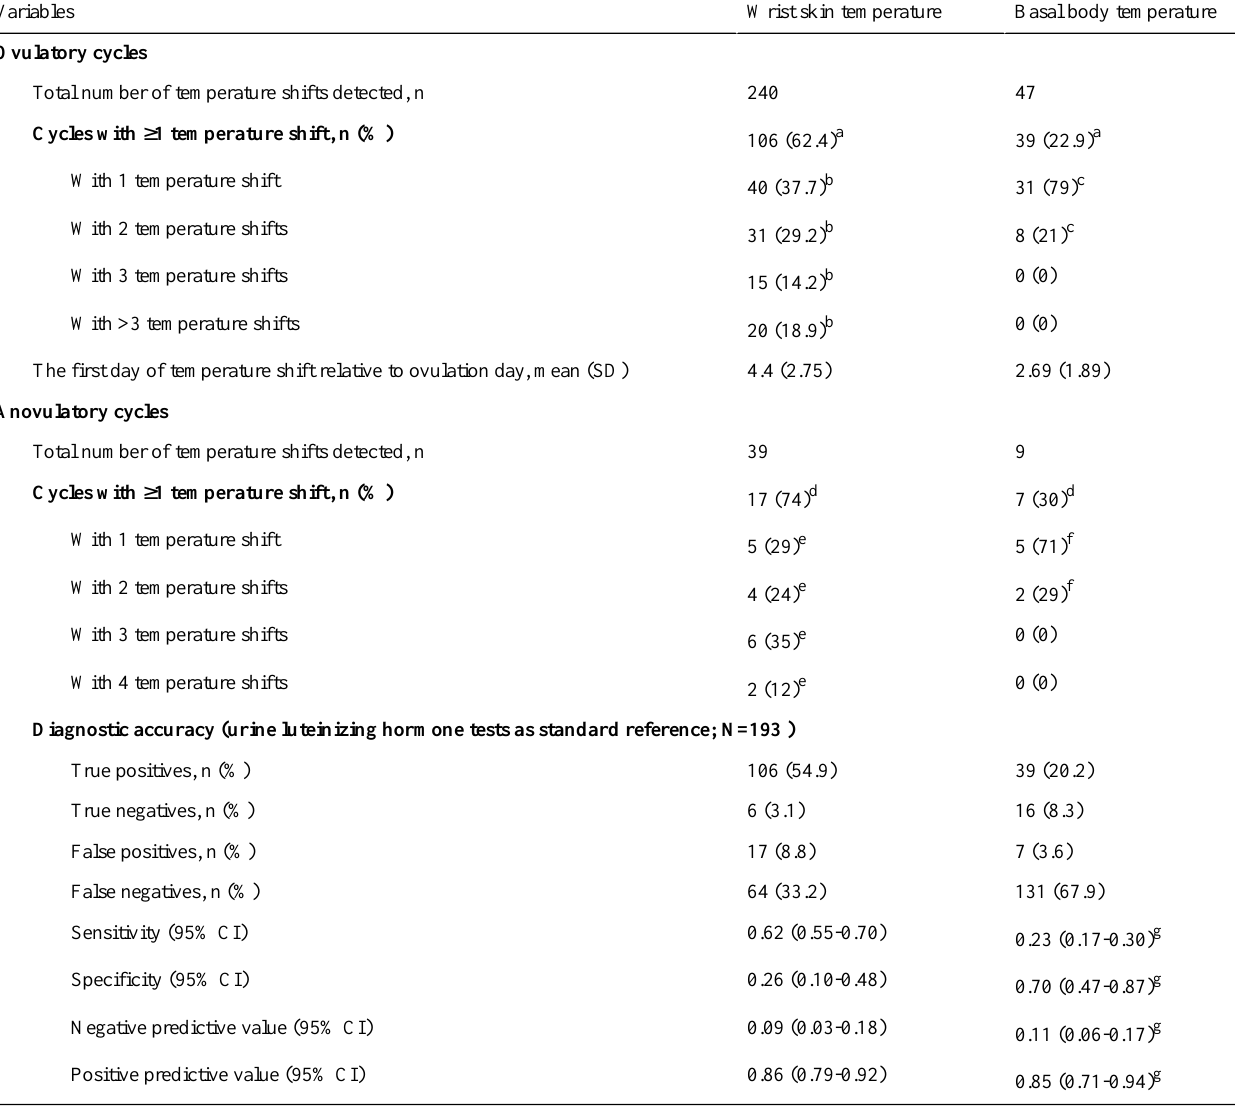
Basal body temperatureWrist skin temperatureVariables